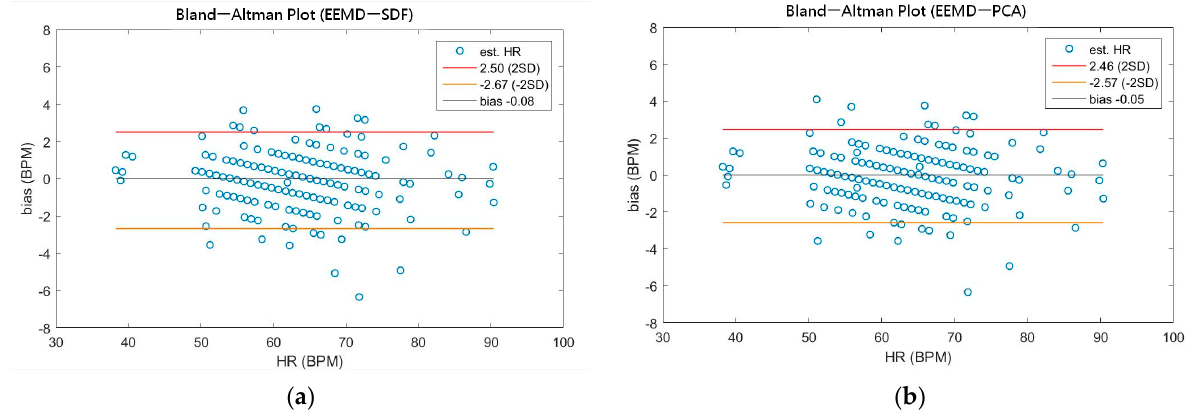
Figure 6. ( a ) The Bland-Altman plot of the estimated HR using EEMD-SDF; ( b ) the Bland-Altman plot of the estimated HR using EEMD-PCA.